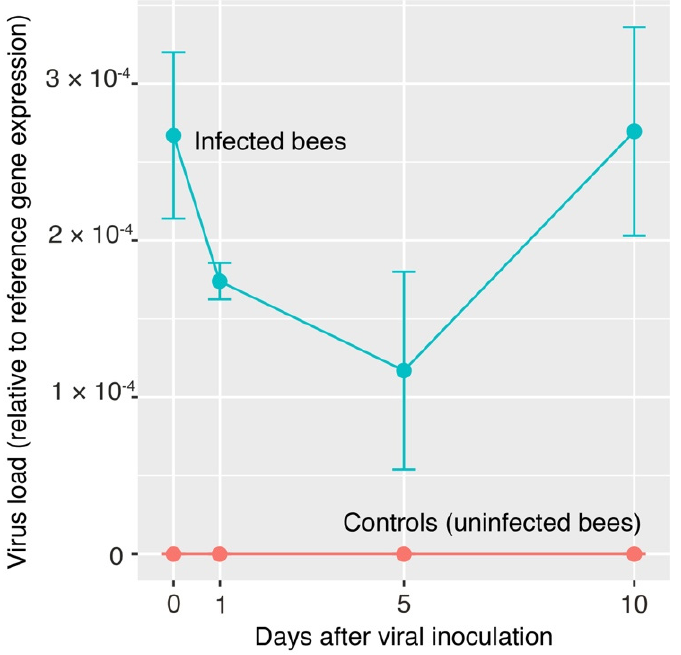
Figure 5. Viral load of honey bees infected with Vespula vulgaris Moku-like virus, relative to reference gene (NDUFA8 and PROS54) expression. Each viral load expression value is the average of three biological replicates. The error bars represent the standard error of the mean (SEM).